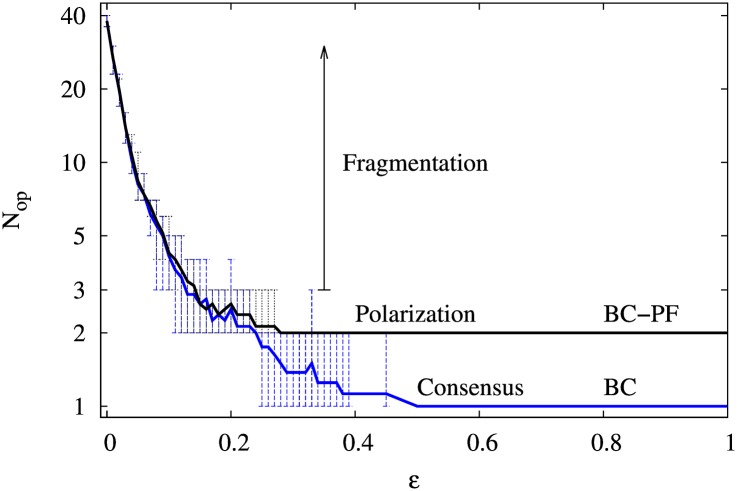
Number of different opinions Nop in final balanced configurations as a function of the bounded confidence parameter ε for 40 agents and p = 0.1.The grey curve corresponds to the BC model and the black curve to the BC-PF model. The curves represent the mean value of Nop in 8 simulations with random initial opinions. The initial links are also set at random with equal probability for friendship (+1) and for enmity (-1). The vertical bars indicate the maximum and minimum values of Nop in the 8 simulations.